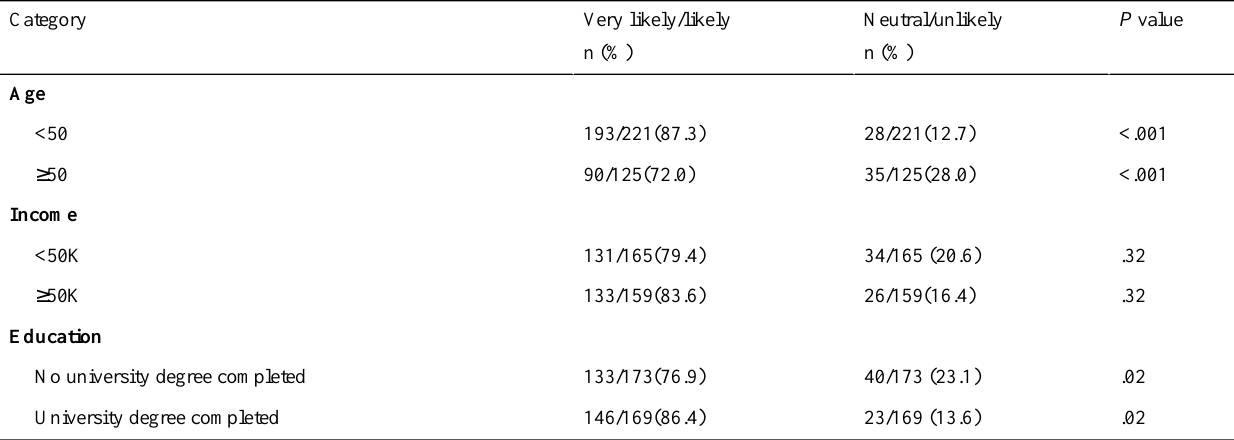
Table 3. Likelihood of reuse rating by patients. a